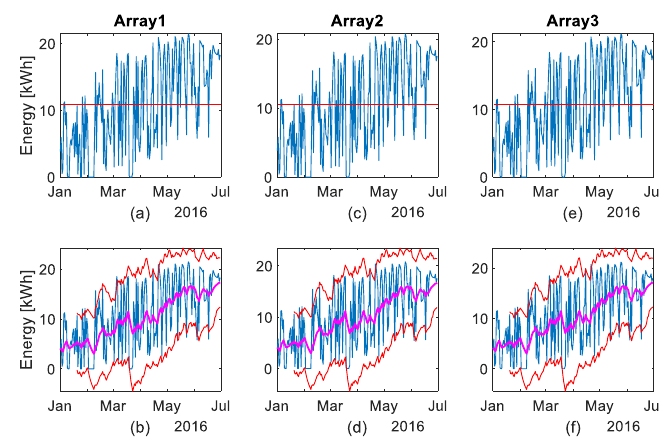
Figure 5. ( a ) Energy produced by array #1 in six months and its mean value as red line; ( b ) upper and lower BB 20 of array #1 in red color, and EMA 20 in magenta color. ( c , d ) refer to array #2. ( e , f ) refer to array #3. Table 2. Mean energy and spread with respect to the global mean for the semester